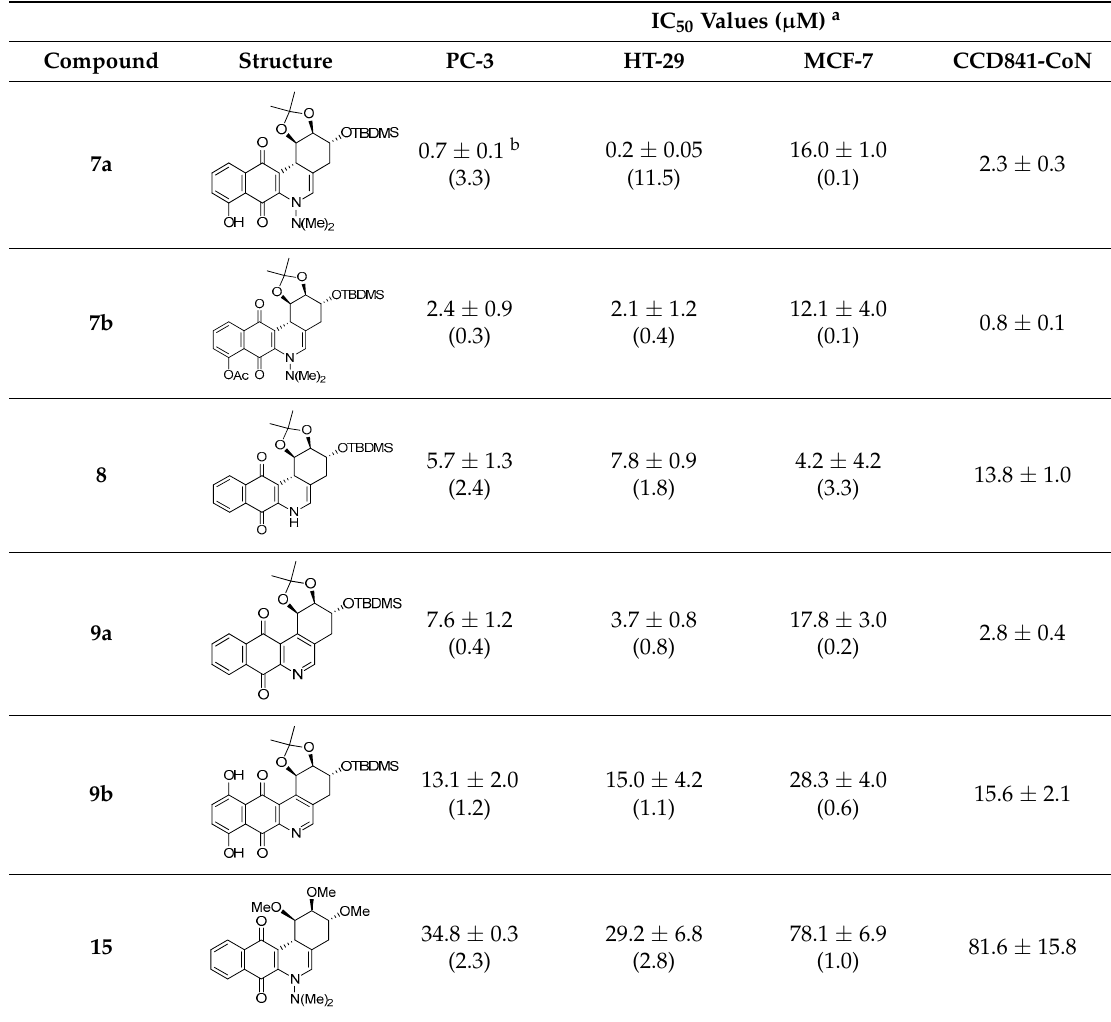
Table 1. In vitro antitumor activity of angucyclinone N -analogues.